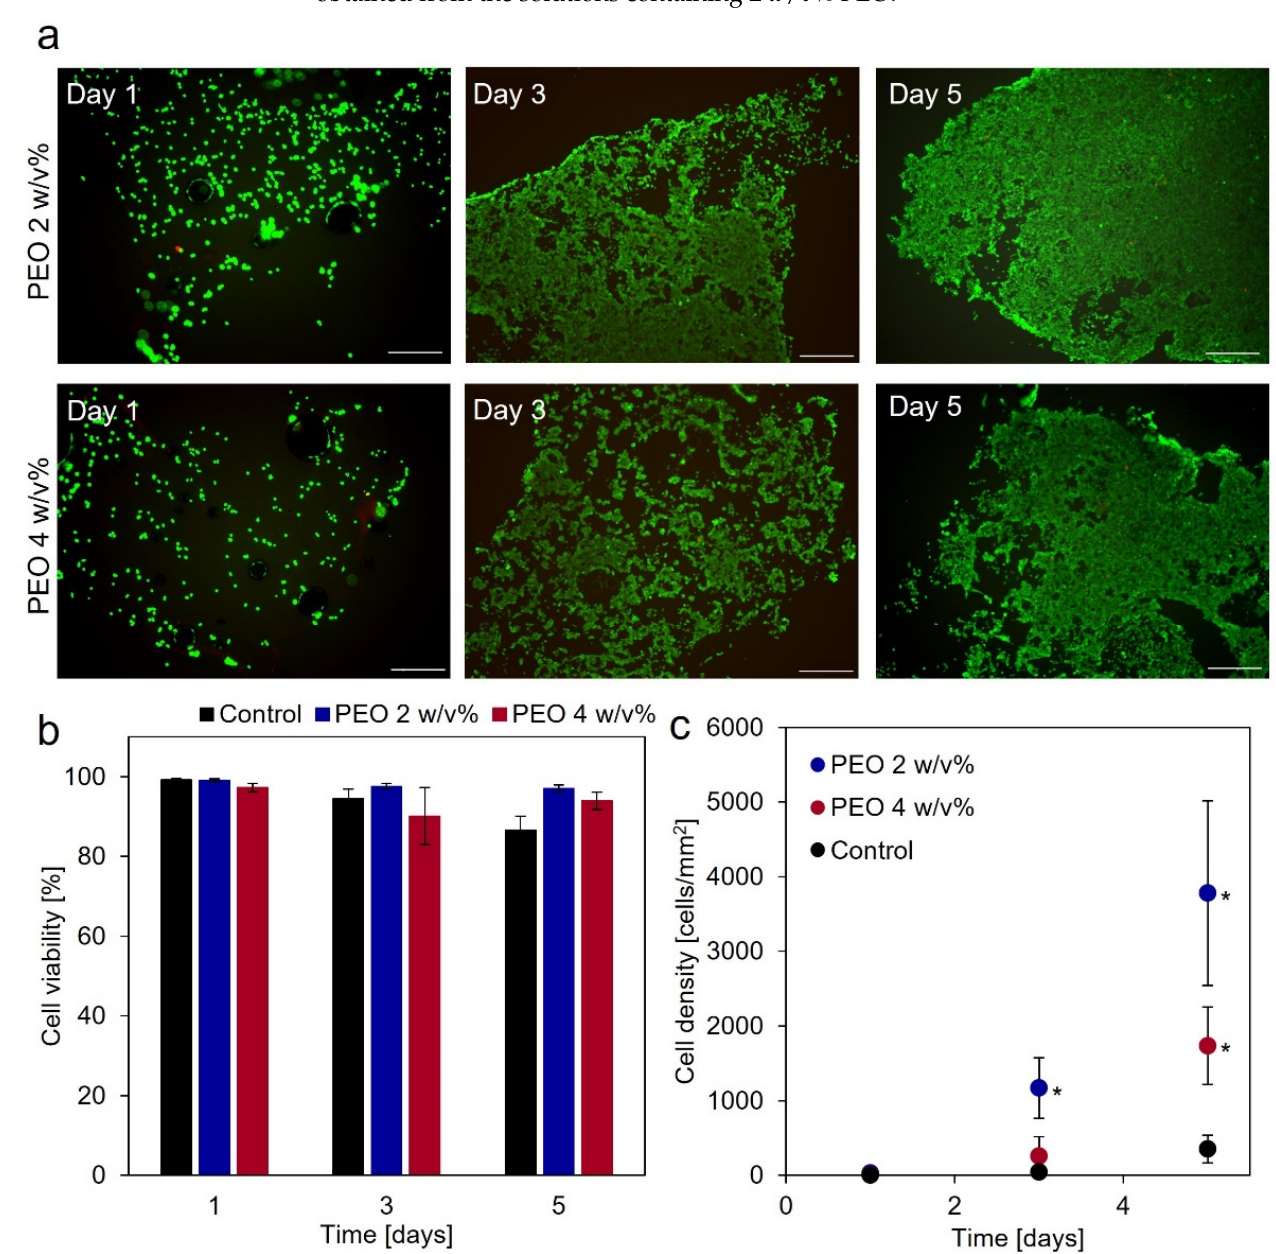
Figure 3. Cytocompatibility of Gelatin-Ph nanofibers obtained from solutions containing 2 and 4 w/v% PEO. ( a ) Fluorescent images of live (green) and dead (red) cells on the nanofibers. Bars are 500 μ m. ( b , c ) Cell viability and density on the nanofibers or the culture dishes (control). The values were measured using a flow cytometer. Data represent mean ± standard deviation (SD; n = 5). * p < 0.05 compared to control.